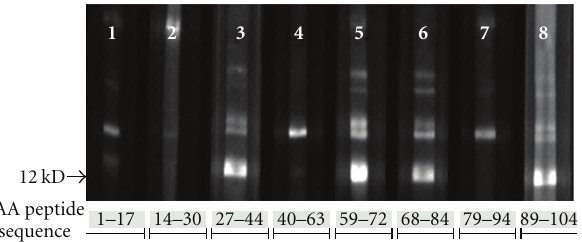
Figure 3: Multimerization of SAA. Human recombinant SAA was blotted onto nitrocellulose membranes and overlayed with poly- clonal antibodies against synthetic SAA human peptides ranging from the indicated amino acid sequences: lane 1: SAA1–17, lane 2: SAA14–30, lane 3: SAA27–44, lane 4: SAA40–63, lane 5: SAA59–72, lane 6: SAA68–84, lane 7: SAA79–94, and lane 8: SAA 89–104. HRP- labeled secondary goat antirabbit antibody was used for secondary incubation followed by luminol and chemiluminescent detection. The SAA monomer at around 12 kD is